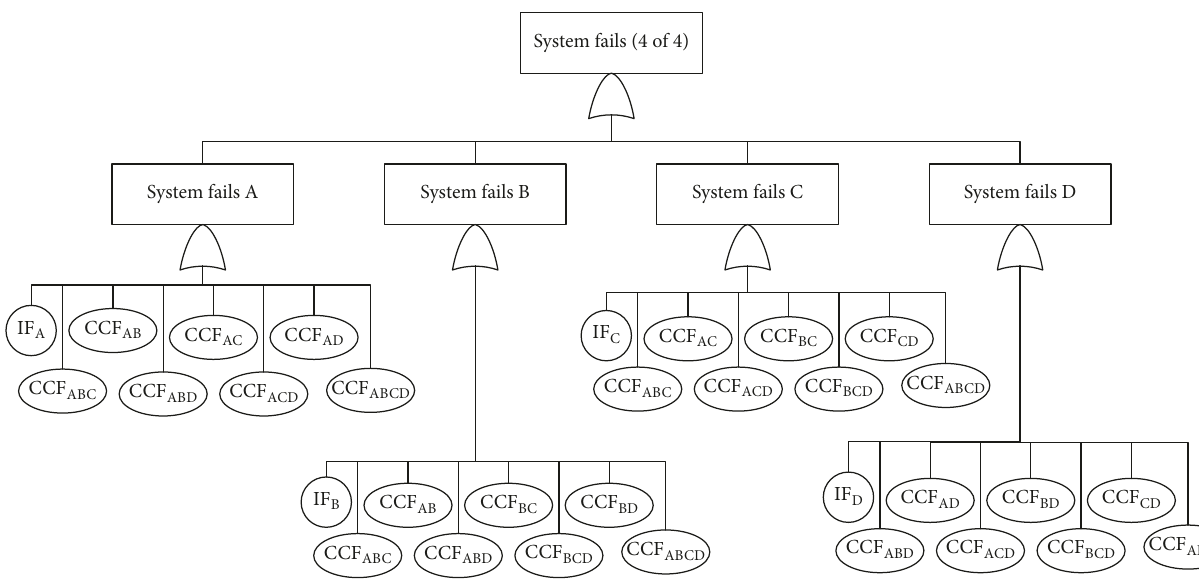
Figure 5: Example of fault tree representing alpha factor model, CCG =